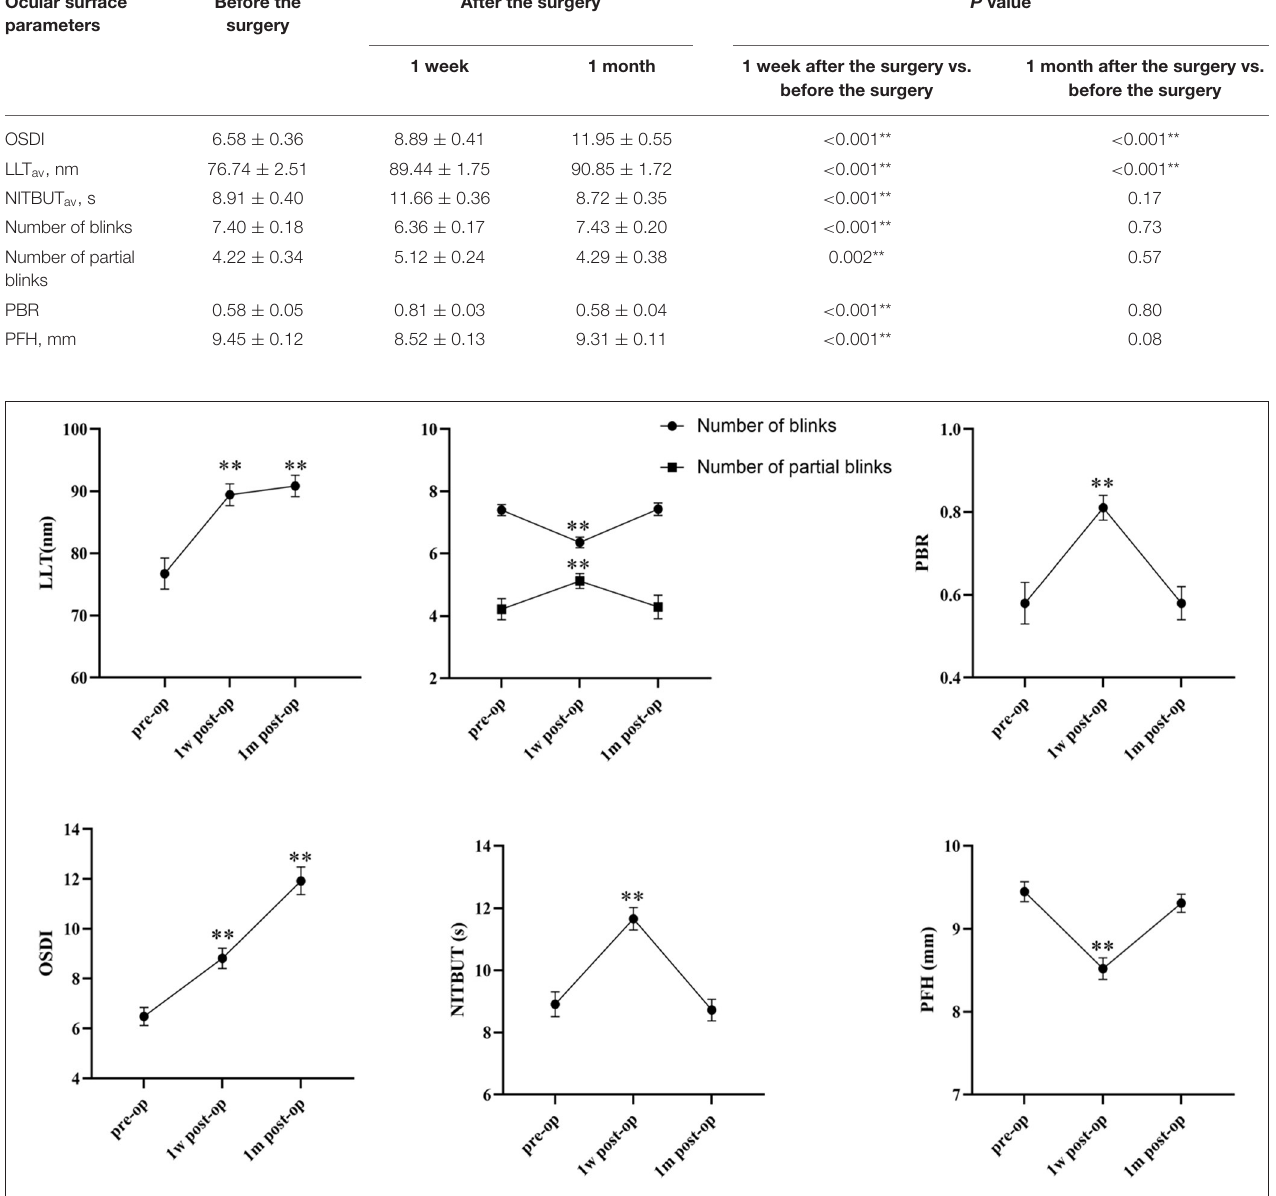
FIGURE 1 | Graph depicting mean and standard error (SE) for OSDI, LLT, NITBUT, PFH, number of blinks, number of partial blinks, and PBR before and after upper blepharoplasty (** P < 0.001) (pre-op, preoperative; post-op, postoperative; 1w, 1 week; 1m, 1